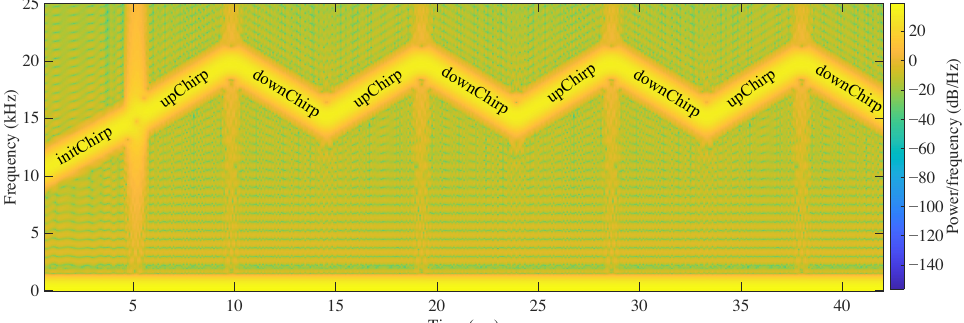
Figure 3. Spectrogram of the emitted signal coded as 10101010.